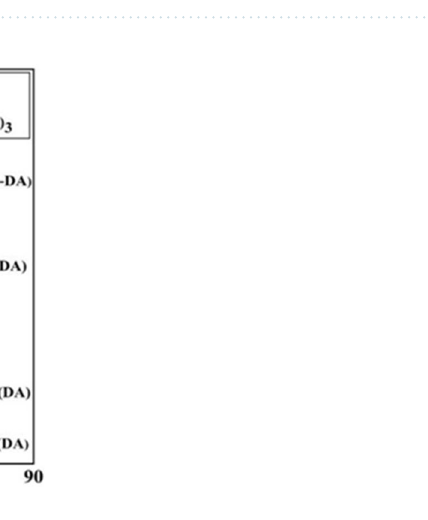
Figure 2. EDS graphs of DA and Al-DA before and after adsorption. ( A ) Before DA adsorption. ( B ) After DA adsorption. ( C ) Before Al-DA adsorption. ( D ) After Al-DA adsorption.